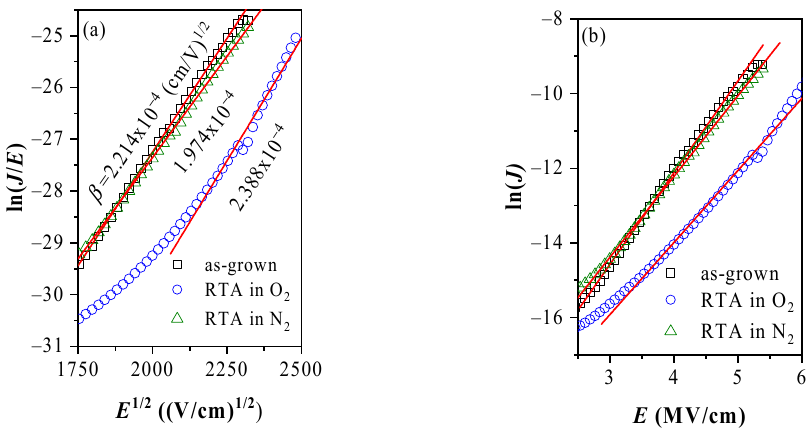
Figure 5. Poole-Frenkel ( a ) and Poole ( b ) plots of J - V characteristics presented in Figure 4. The values of β are calculated for r = 1.